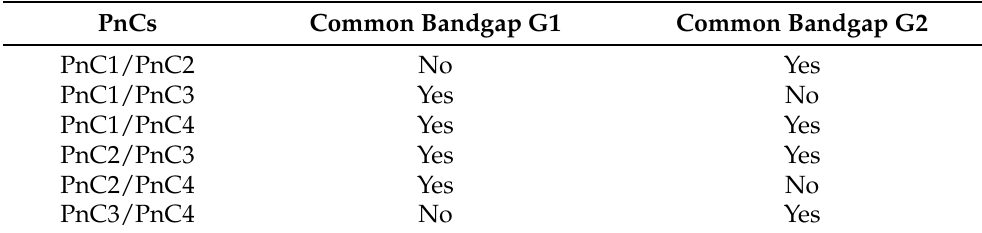
Table 1. The existence or nonexistence of topological interface states for different interface configura- tions constructed from the four PnCs in Figure